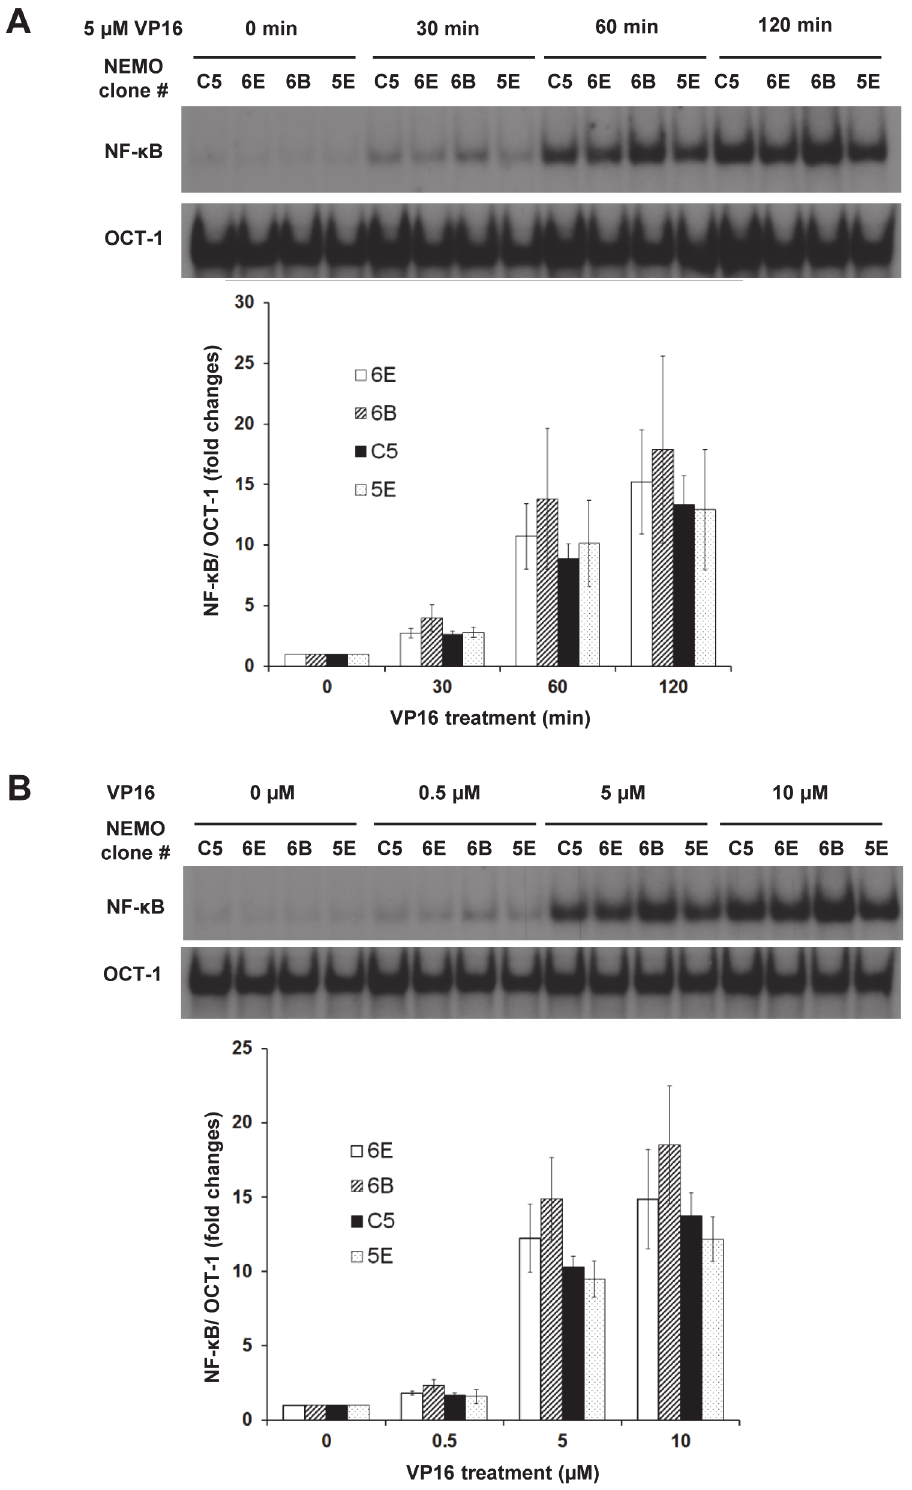
Fig 5. Effects of NEMO amount on NF- κ B activation in response to etoposide. (A) Time course analysis. The indicated 1.3E2 clones were left untreated or treated with 5 μ M VP16 for indicated times and analyzed by EMSA. Three independent experiments were performed as above on different days. The NF-kB bands were quantified and fold inductions of NF- κ B DNA binding activity were graphed below. Error bars